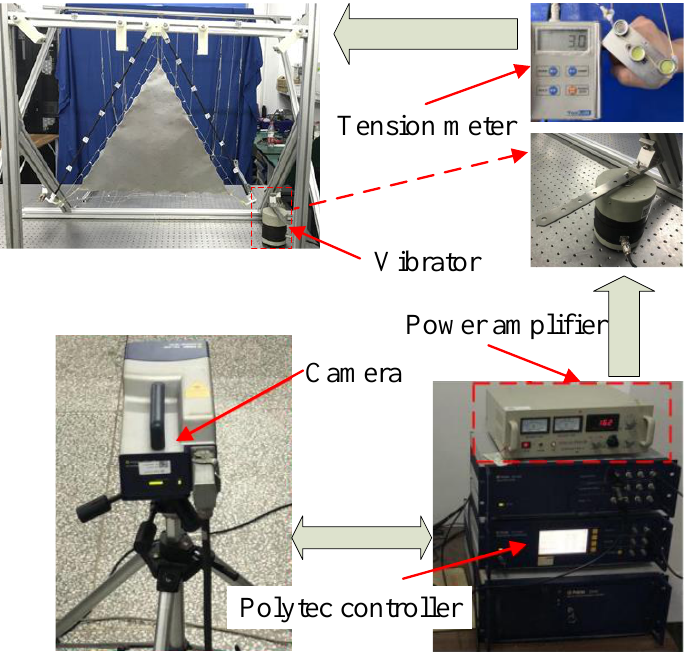
Figure 8. Modal test of membrane mechanism.